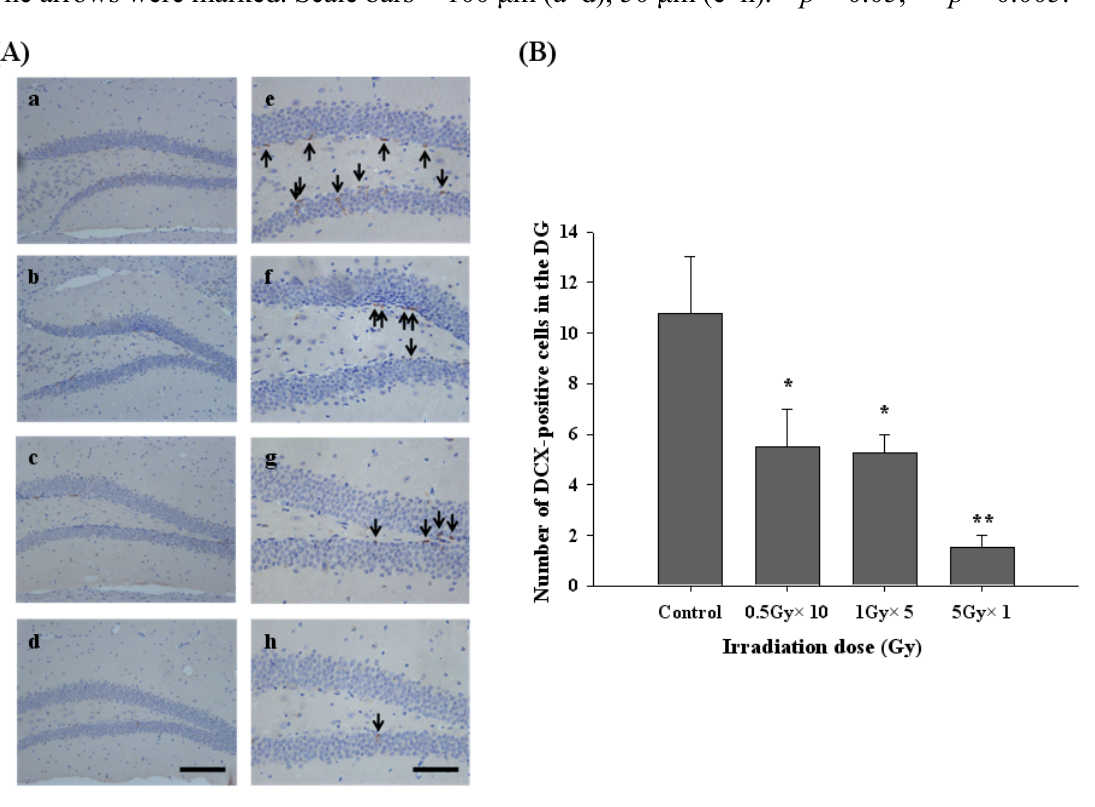
Figure 2. Long-term effect of acute and fractionated irradiation in subgranular zone (SGZ) of the hippocampal dentate gyrus (DG). ( A ) Histological results in images ( B ). The quantitative values of DCX-positive cells. Immunohistochemistry of DCX in the DG of the hippocampus in four groups of mice. Comparison profiles of DCX expression of the control (a and e), 0.5 Gy × 10 times (b and f), 1 Gy × 5 times (c and g), 5 Gy × 1 times (d and h) groups. The bar graphs indicate the number of DCX-positive cells/DG (mean ±